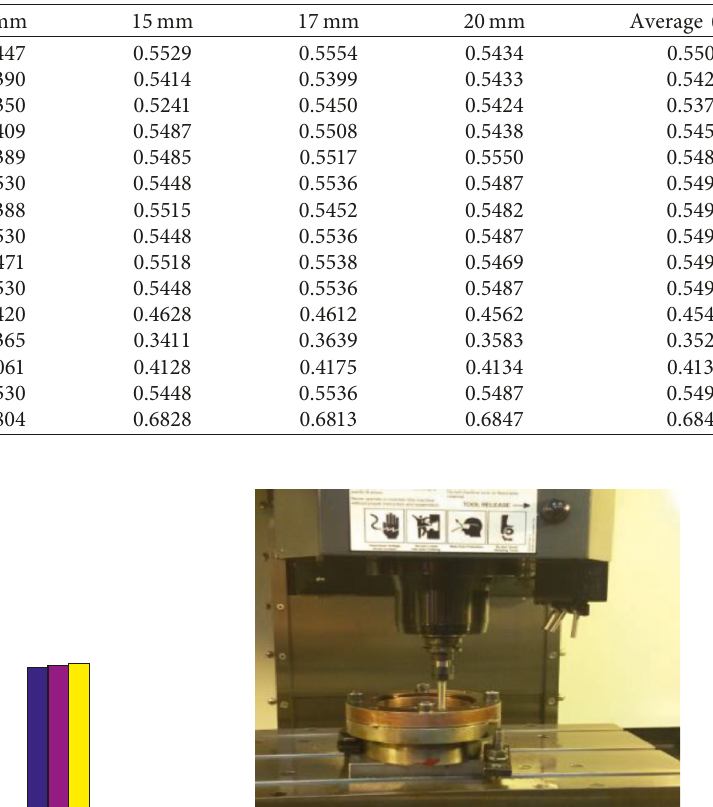
Figure 6: Simulation results. Table 4: Thickness value.